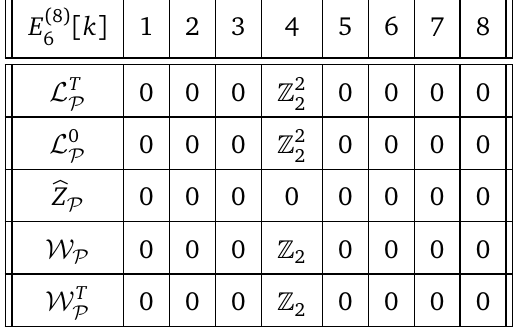
Table 8: Various contributions to the defect group for the untwisted punctures ( 8 ) [ k ] of type E N = ( 2,0 ) theory. The columns parametrize different values of k P 6 6